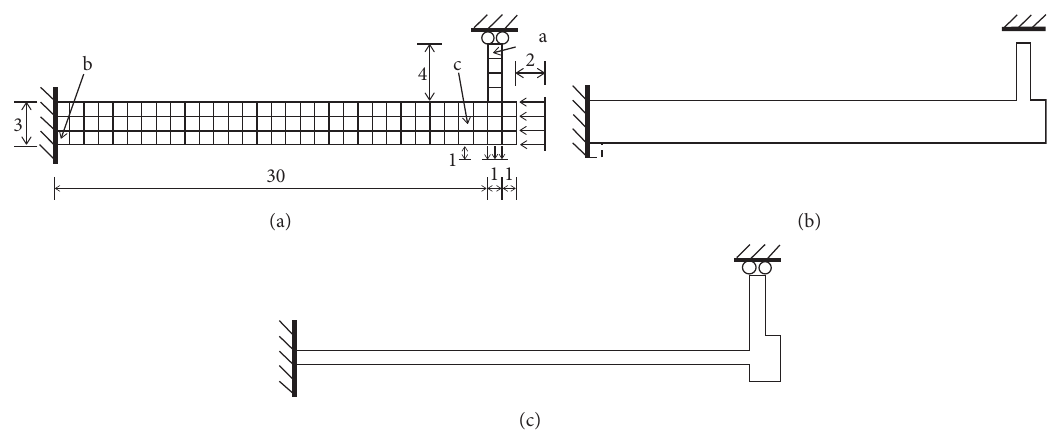
Figure 1: Zhou-Rozvany counterexample: (a) initial design domain with FE mesh, (b) topology given by ESO’s rejection criterion for 1% volume reduction, and (c) conceivable optimal solution for 60% volume reduction and the first line of the